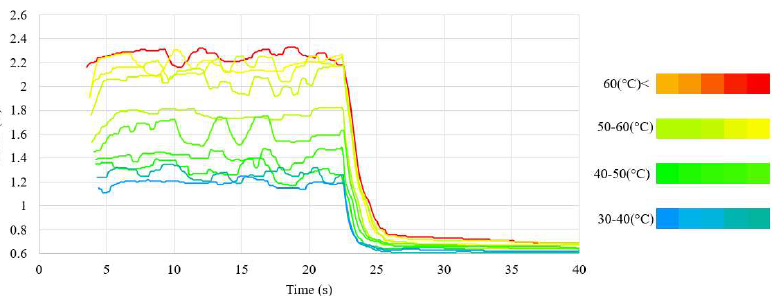
Figure 10. Waveform of the displacement in relation to the average temperature during heating (test sample diameter, 100 μm).